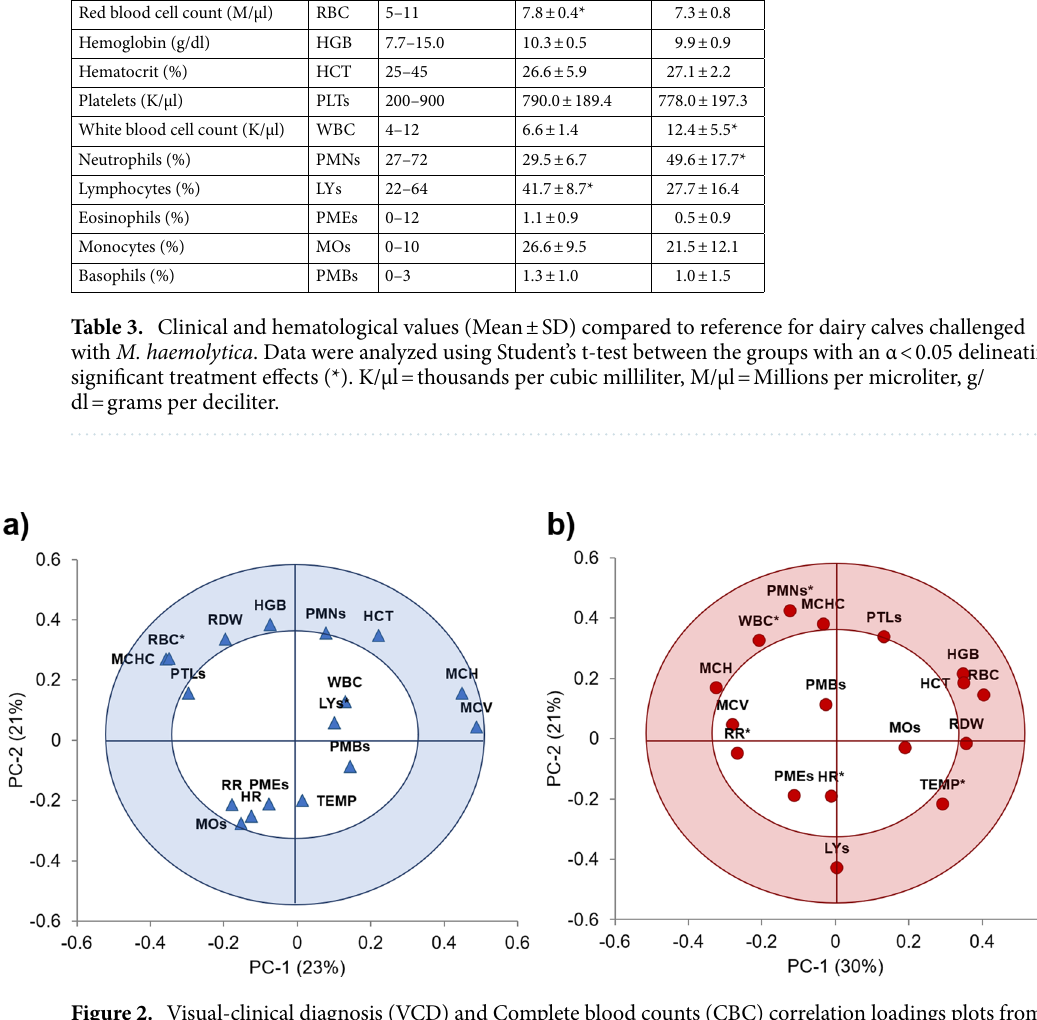
Figure 2. Visual-clinical diagnosis (VCD) and Complete blood counts (CBC) correlation loadings plots from the principal component analysis (PCA). The variables closest to the outer circle (shaded area) have the most influence in the variability of the database and are positively or negatively correlated with the disease stage of the dairy calves (n = 5); the points inside the inner circle are considered to have little or no influence. ( a ) Baseline or healthy calves; two PCs explained 44% of the variance, here as expected, the VCD variables and the white blood cell count (WBC) showed no influence. ( b ) Infected or challenged calves with M. haemolytica , two PCs explained 51% of the variation of the database. During this state of the disease the activation of the innate immunity showed a negative correlation in the rectal temperature (TEMP) and a positive correlation with the WBC and neutrophils (polymorphonuclears,